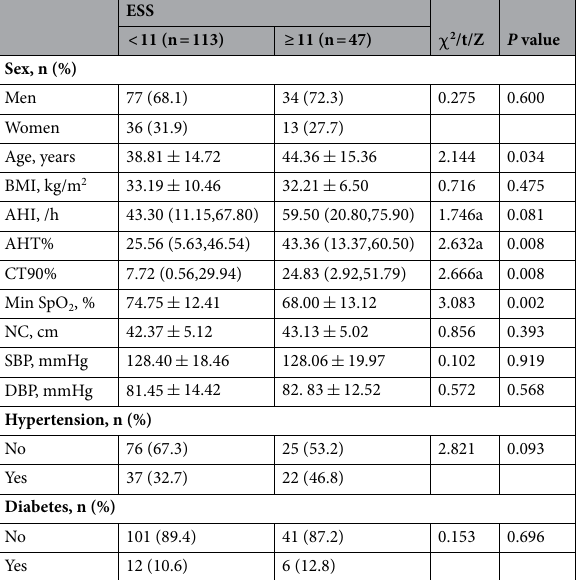
Table 3. Characteristics of OSA patients classified by ESS < 11 or ESS ≥ 11. a Mann-Whitney U